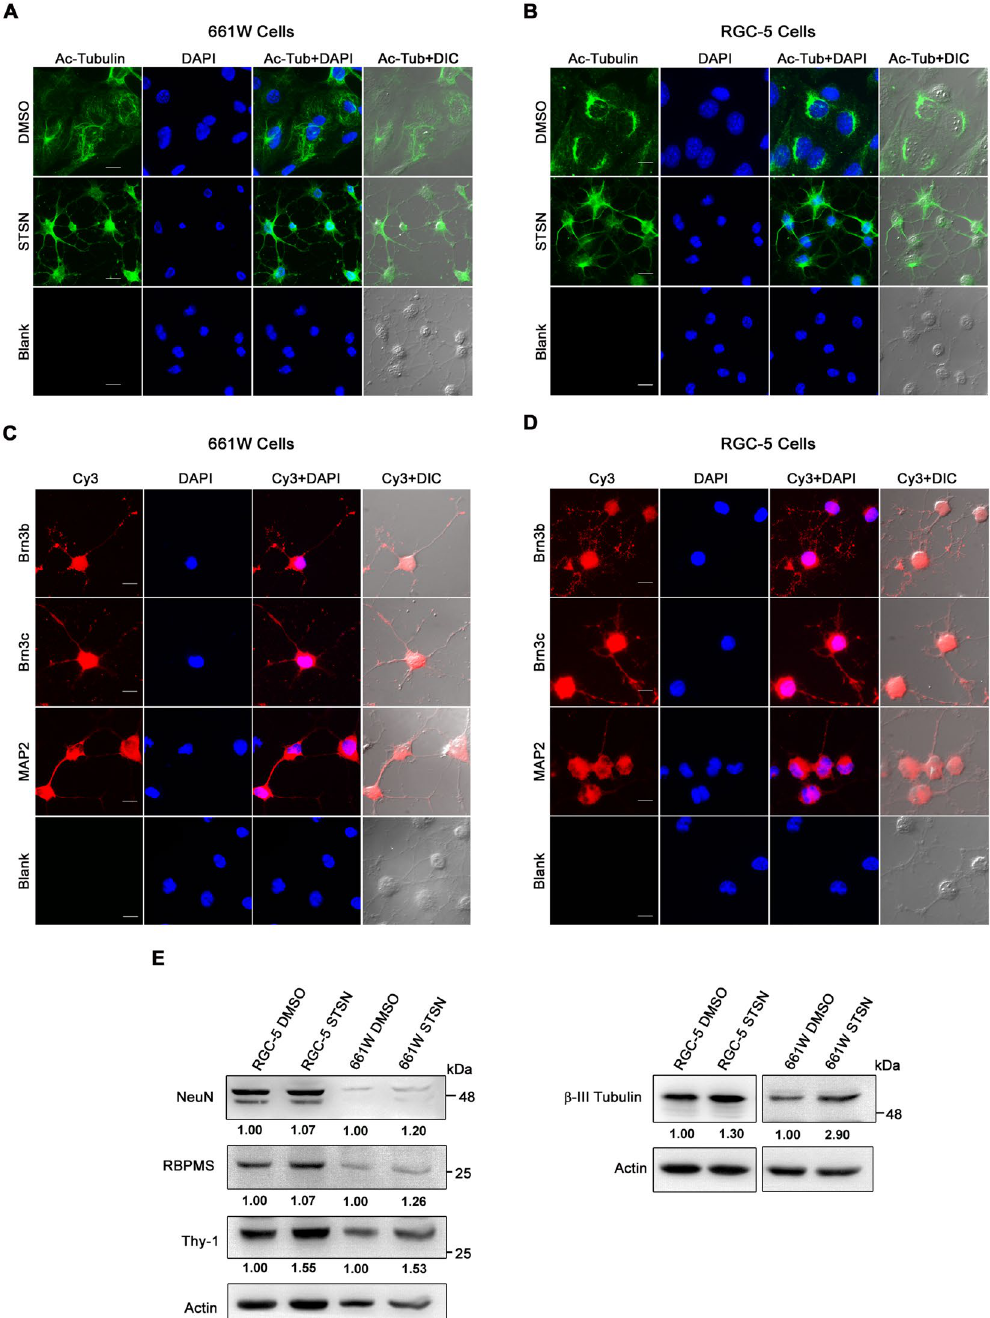
Figure 4. Morphological analysis and differentiation of 661W and RGC-5 cells. 661W ( A , C ) and RGC-5 cells ( B , D ) were treated with 316 nM staurosporine (STSN) or vehicle (DMSO) for 24 hours, fixed and stained with specific antibody for acetylated tubulin ( A , B ). Staurosporine treatment induced neurite formation in 661W as well as RGC-5 cells. Scale bar: 10 µ m. ( C , D ) Immunostaining of 661W and RGC-5 cells for RGC markers Brn3b, Brn3c and neuronal marker MAP-2 with antibodies. Scale bar, 10 µ m. ( E ) Western blots showing the effect of differentiation with staurosporine on the level of Thy1, RBPMS, beta-III tubulin and NeuN proteins in 661W and RGC-5 cells. Numbers below the blots indicate quantitation of expression in differentiated cells relative to undifferentiated cells adjusted with actin loading